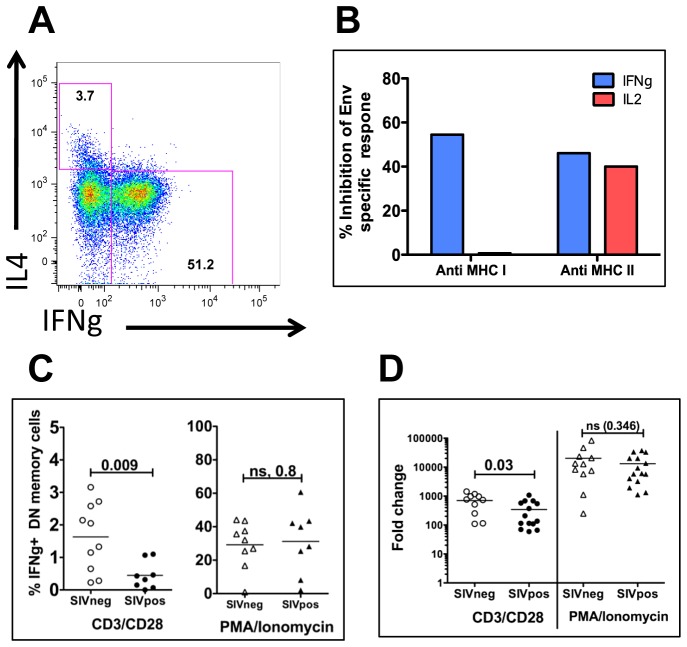
Cytokine expression (flow cytometric and quantitative real-time PCR) and MHC restricted response of DN T cells.A) Representative flow cytometry plot of IFNγ protein expression (x-axis) and IL4 protein expression (y-axis) indicating that different DN subpopulations generally express either IFNγ or IL4 (not both). B) Quantification of the percent inhibition of SIV-Env peptide specific responses within DN T cells in the presence of MHC I (left side) or MHC II (right side) specific antibodies. Intracellular cytokine staining identifies IFNγ (blue) or IL2 (red) expressed by DN T cells within PBMC of a SIV infected mangabey. There was minimal inhibition of IL2 expression in the presence of MHC-I antibody. C) Flow cytometric analysis of mangabey PBMCs, indicating that TCR stimulation results in a greater percentage of DN T cells expressing IFNγ protein in uninfected compared to SIV+ mangabeys. In contrast, mitogenic stimulation (PMA/Ionomycin) did not result in any difference in IFNγ expression between these two groups. D) IFNγ mRNA expression indicating an increased expression of IFNγ mRNA from DN T cells from uninfected mangabeys upon stimulation through their TCR, but not when stimulated with PMA/Ionomycin.